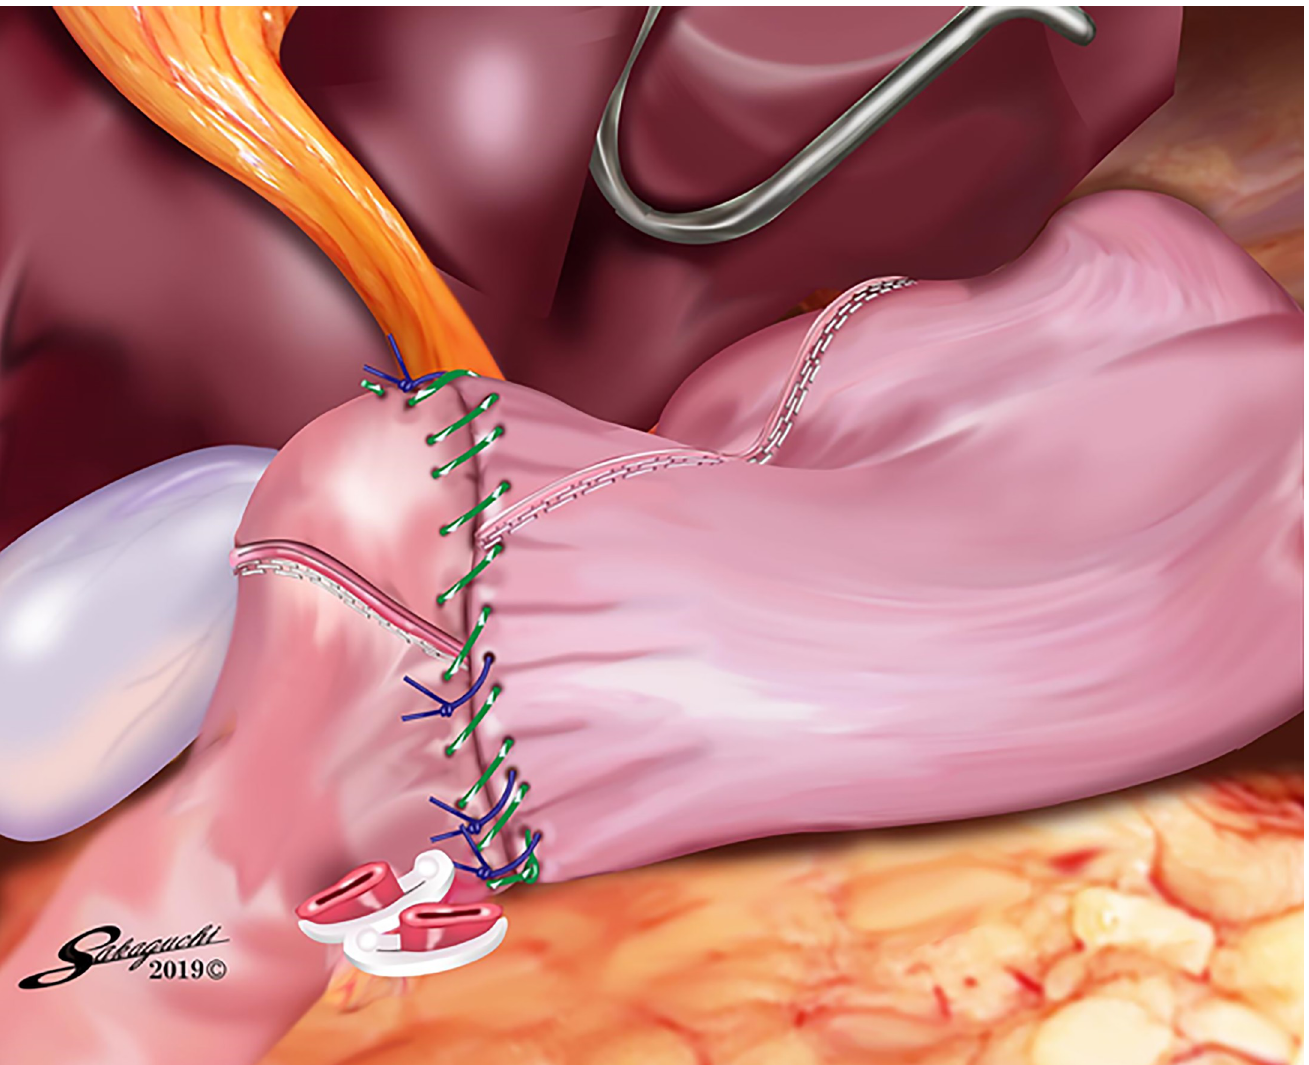
Fig 6. The modified DSG with linear stapling and single-layer hand suturing. The modified DSG with linear stapling and single-layer hand suturing is completed.